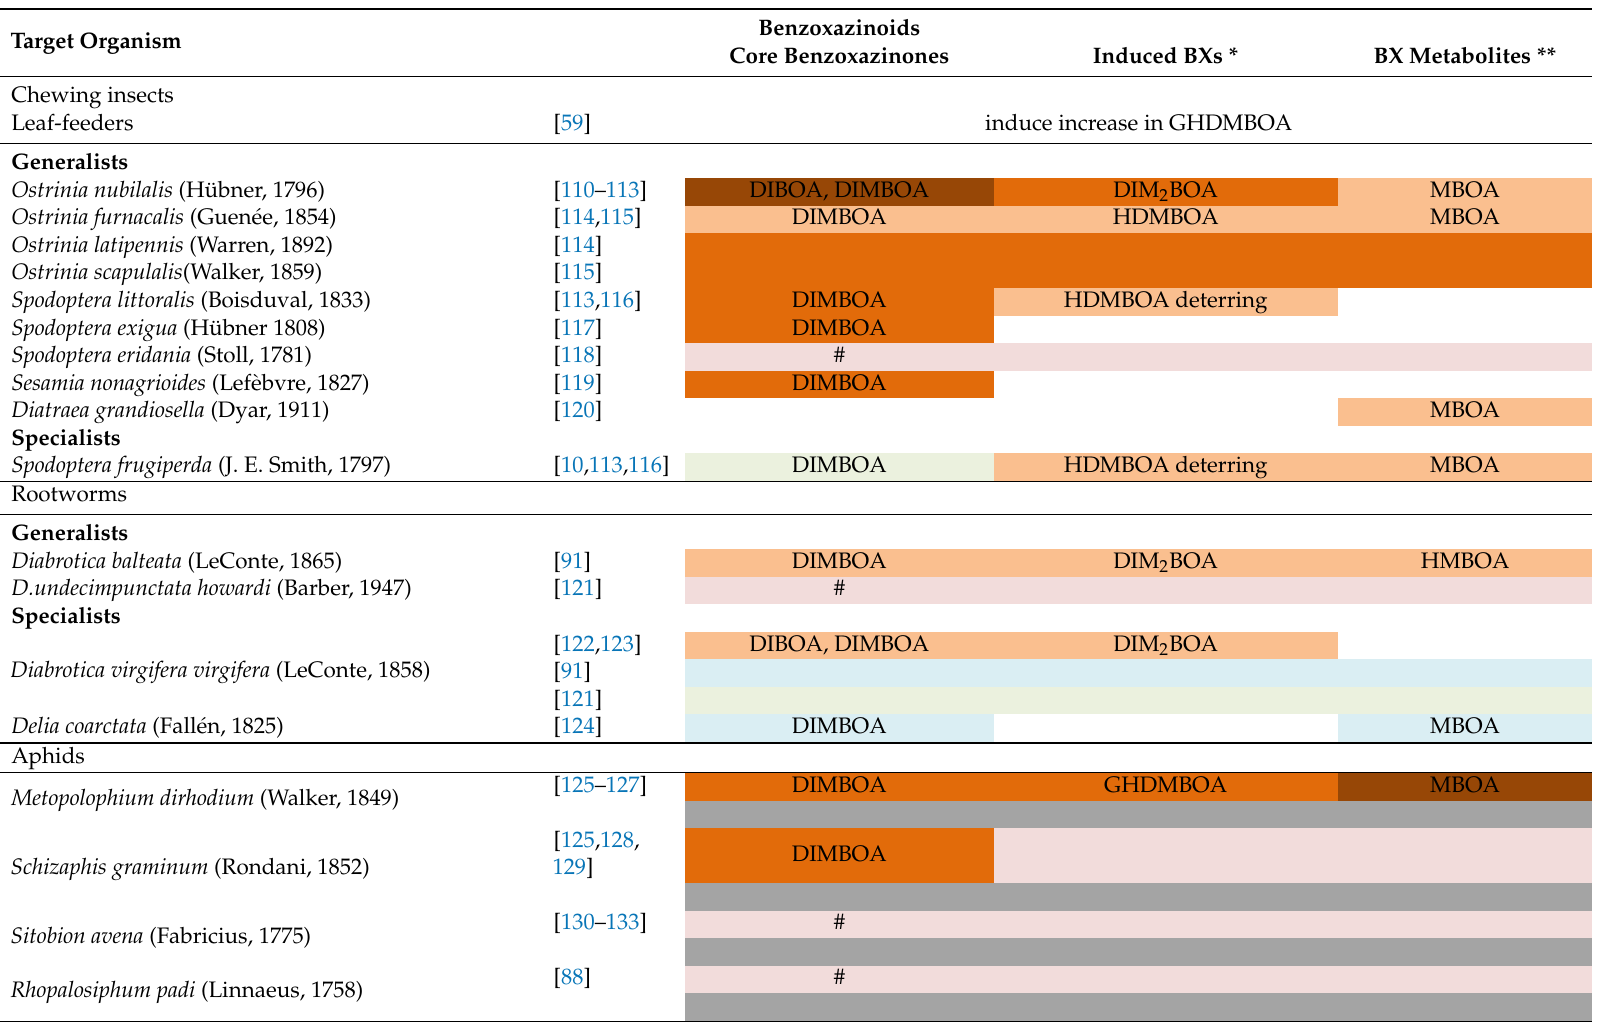
Table 1. Impact of different BX families on target organisms and their effective